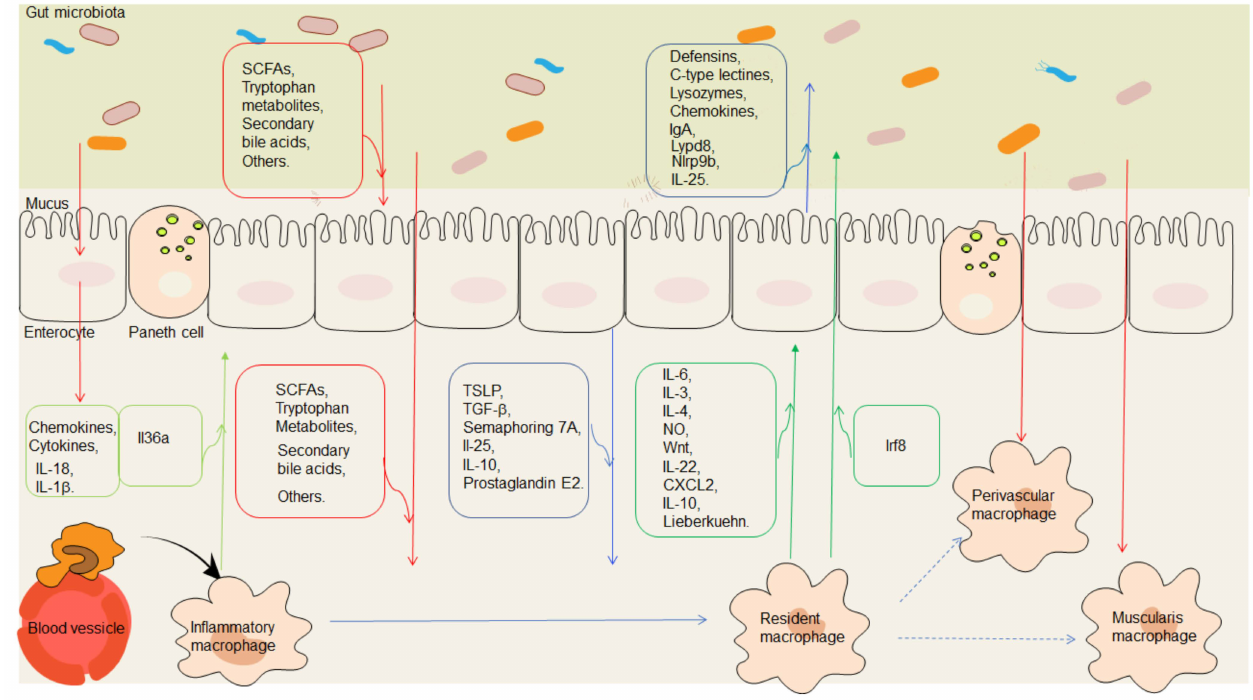
Figure 1. A special network comprised of macrophages, the gut microbiota, and epithelial cells for gut homeostasis. Immunological mediators, including cytokines and chemokines secreted from the gut epithelial cells stimulated by gut microbiota, such as IL-18 and IL-1 β , modulate host